Question: Identify the chart type used in this figure.
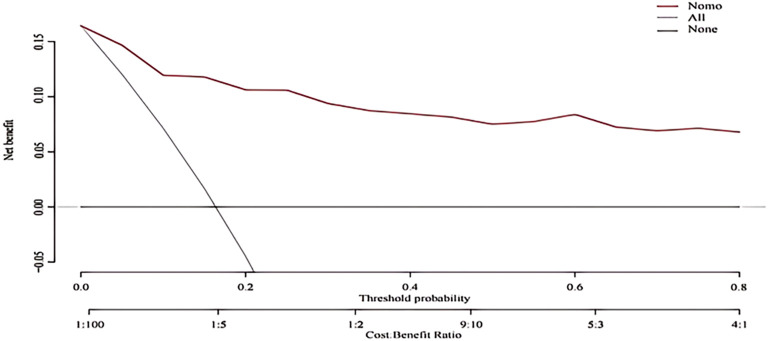
Answer: line